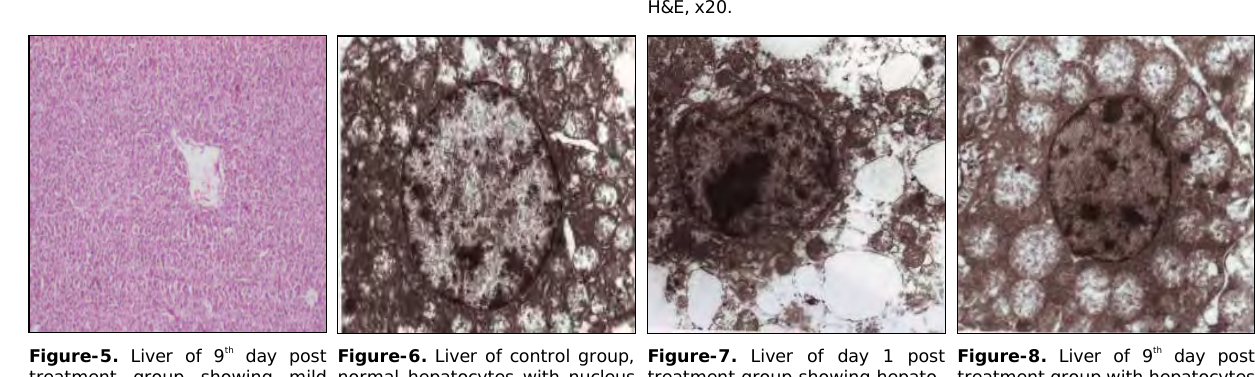
th Figure-4 . Liver of 5 day post rd Figure-3. Liver of 3 day post treatment chicken showing focal treatment group showing no areas of infiltrated inflammatory sinusoidal spaces indicating cells. H&E, x20. swollen hepatocytes and few areas of vacuolar degeneration. H&E, x20.